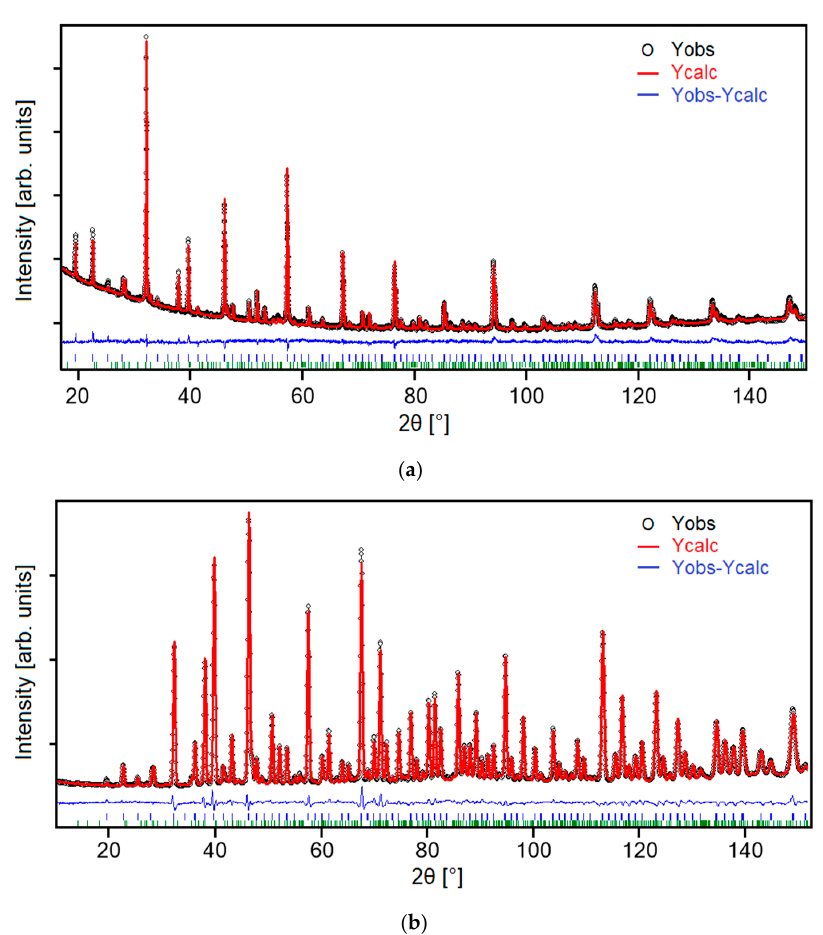
Figure 2. Combined Rietveld refinement of ( a ) PXRD data; ( b ) NPD data. Bragg peak positions are indicated as vertical lines below the difference curve, LAMT in blue, La 3 TaO 7 in green.